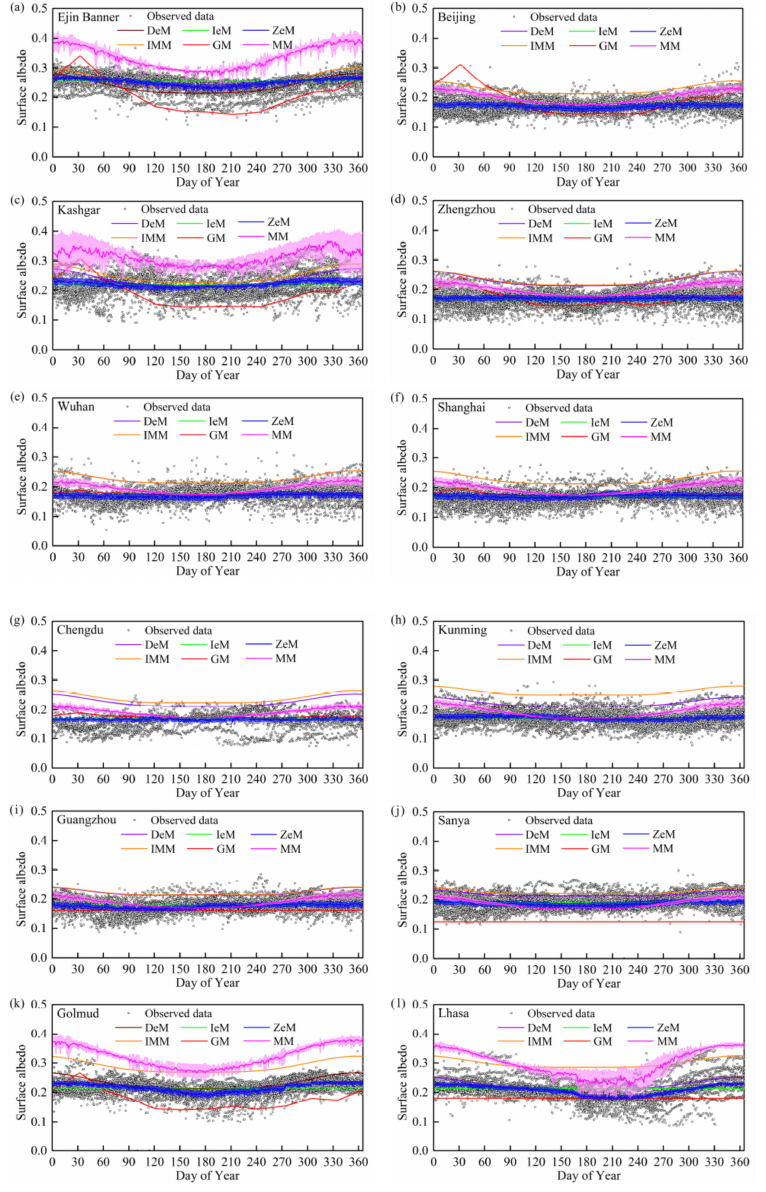
Figure 5. Comparisons of estimated results with measured data at ( a ) Ejin Banner, ( b ) Beijing, ( c ) Kashgar, ( d ) Zhengzhou, ( e ) Wuhan, ( f ) Shanghai, ( g ) Chengdu, ( h ) Kunming, ( i ) Guangzhou, ( j ) Sanya, ( k ) Golmud, and ( l ) Lhasa